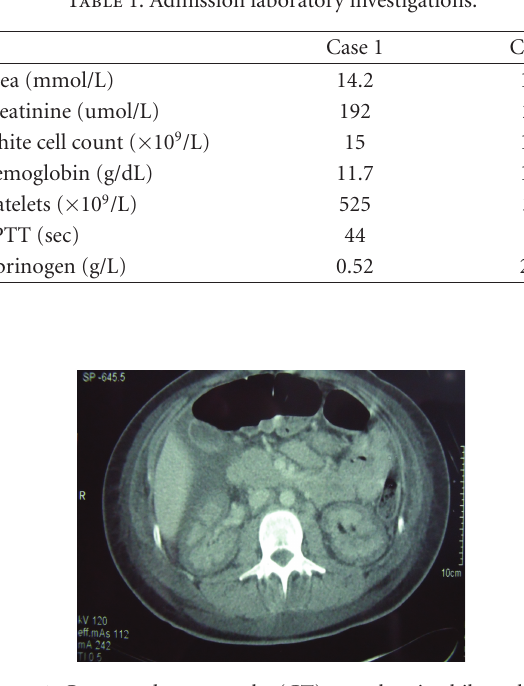
Figure 1: Computed tomography (CT) scan showing bilateral renal infarcts.